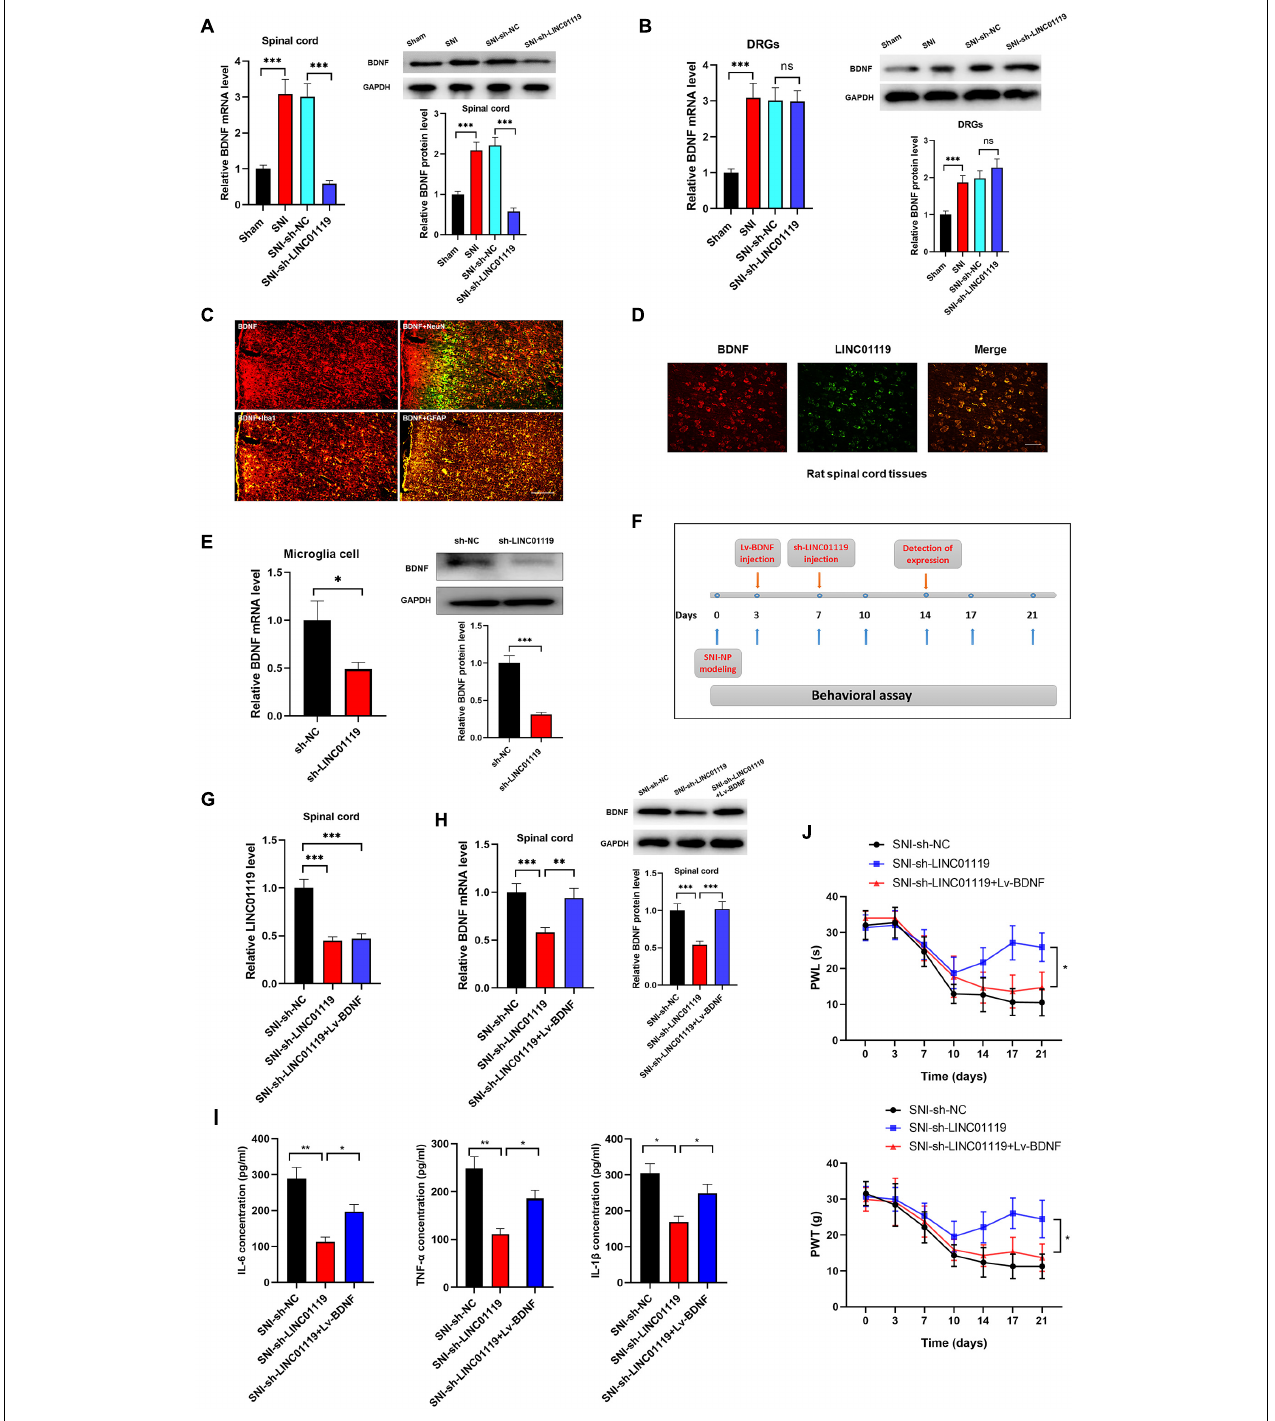
FIGURE 3 | LINC01119 mediated NP progression via targeting BDNF. (A) BDNF mRNA (left panel) and protein (right panel) were upregulated in spinal cord tissue of SNI rats and downregulated by intrathecal injection of sh-LINC01119 in contrast to sham rats, *** P < 0.001, n = 3/group. (B) BDNF mRNA (left panel) and protein (right panel) were upregulated in DRGs of SNI rats, but was not regulated by sh-LINC01119, *** P < 0.001, n = 3/group. (C) Localization of BDNF in the spinal cord of SNI rats by double immunofluorescence of BDNF (red) with NeuN (marker of neuron, merged as yellow), lba1 (marker of microglia, merged as yellow), and GFAP (marker of astrocyte, merged as yellow). Scare bar = 100 µ m. (D) FISH analysis revealed a co-localization of LINC01119 and BDNF in spinal cord. Scare bar = 100 µ m. (E) BDNF was downregulated in microglia cells silenced with LINC01119 at both transcript and protein levels compared to control group, * P <